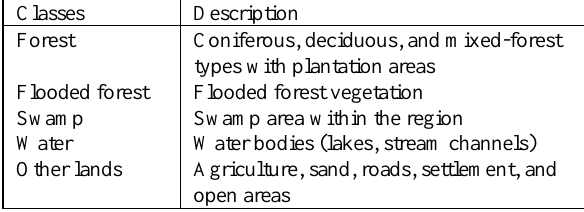
Table 1. The classes used in classification process